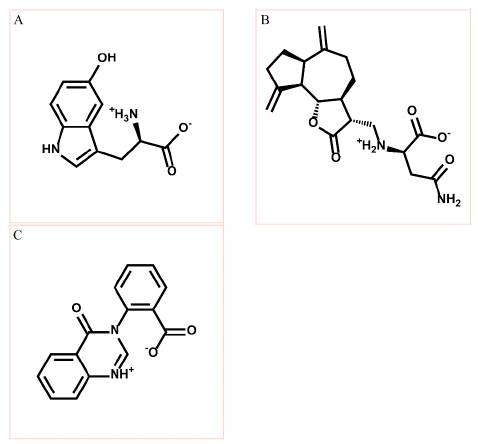
Figure 2. Chemical scaffold of top three TCM candidates, ( A ) 5-hydroxy- L -tryptophan; ( B ) saussureamine C; and ( C ) 3-(2-carboxyphenyl)-4(3 H )-quinazolinone. Table 1. Scoring functions of top candidates from TCM database screening and correlated residues of paraplegin for H-bonds.